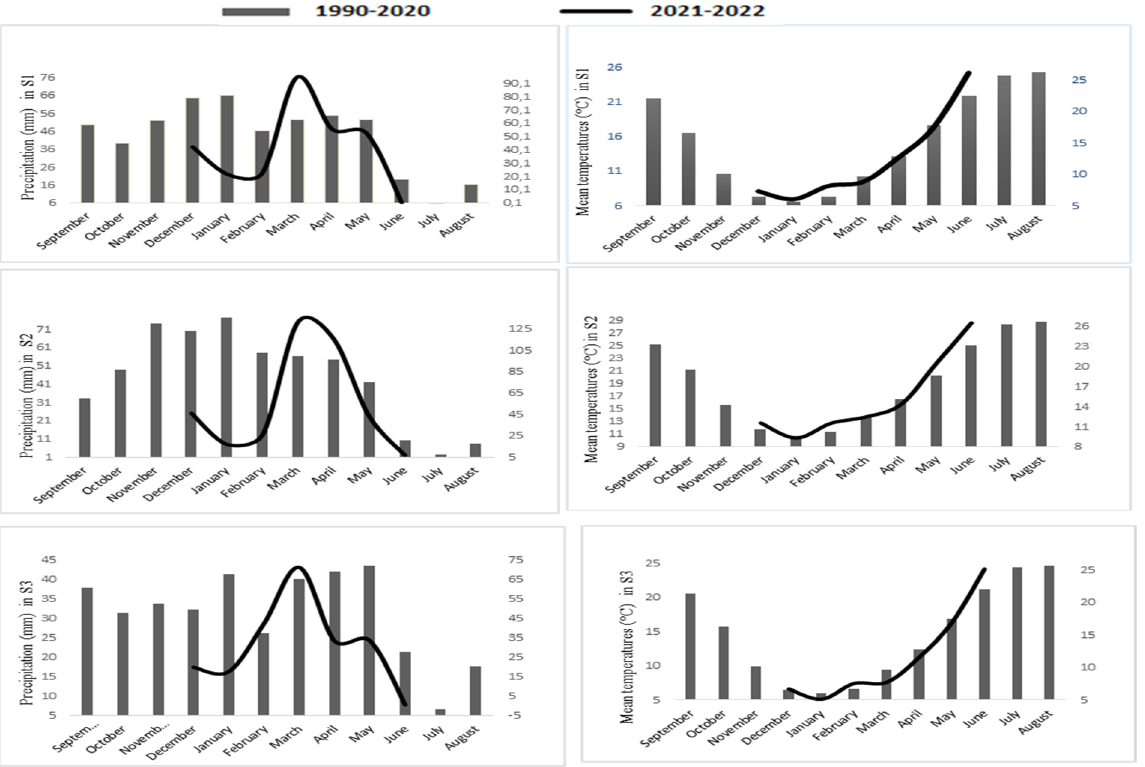
Figure 1. Monthly temperatures and precipitation over the 2021–2022 growing season and inter-annual mean values recorded over the period 1990–2020 at the three experimental sites (S1, S2, and S3). Meteorological data were collected from the website of the National Office of Meteorology in Setif (Algeria) (https://www.infoclimat.fr/observations-meteo/archives/1er/janvier/2019/setif/60445.html). (accessed on 12 August 2022).